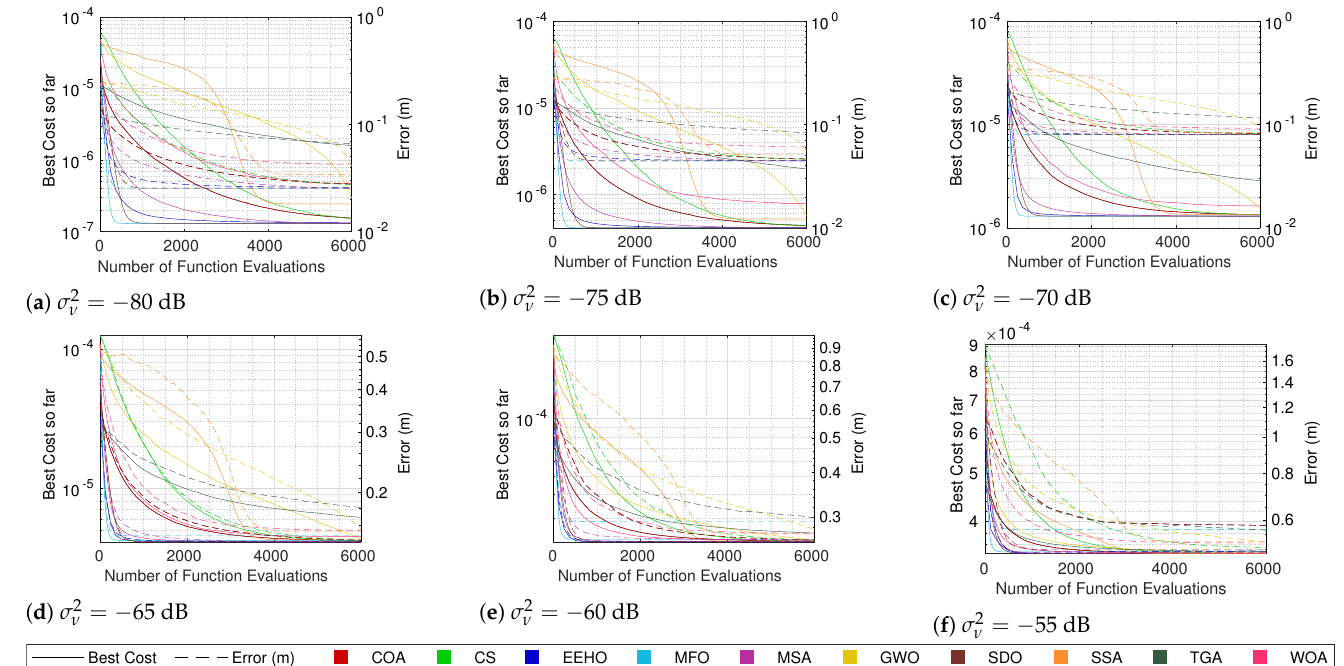
Figure 6. Cost convergence and respective error for each algorithm when N =